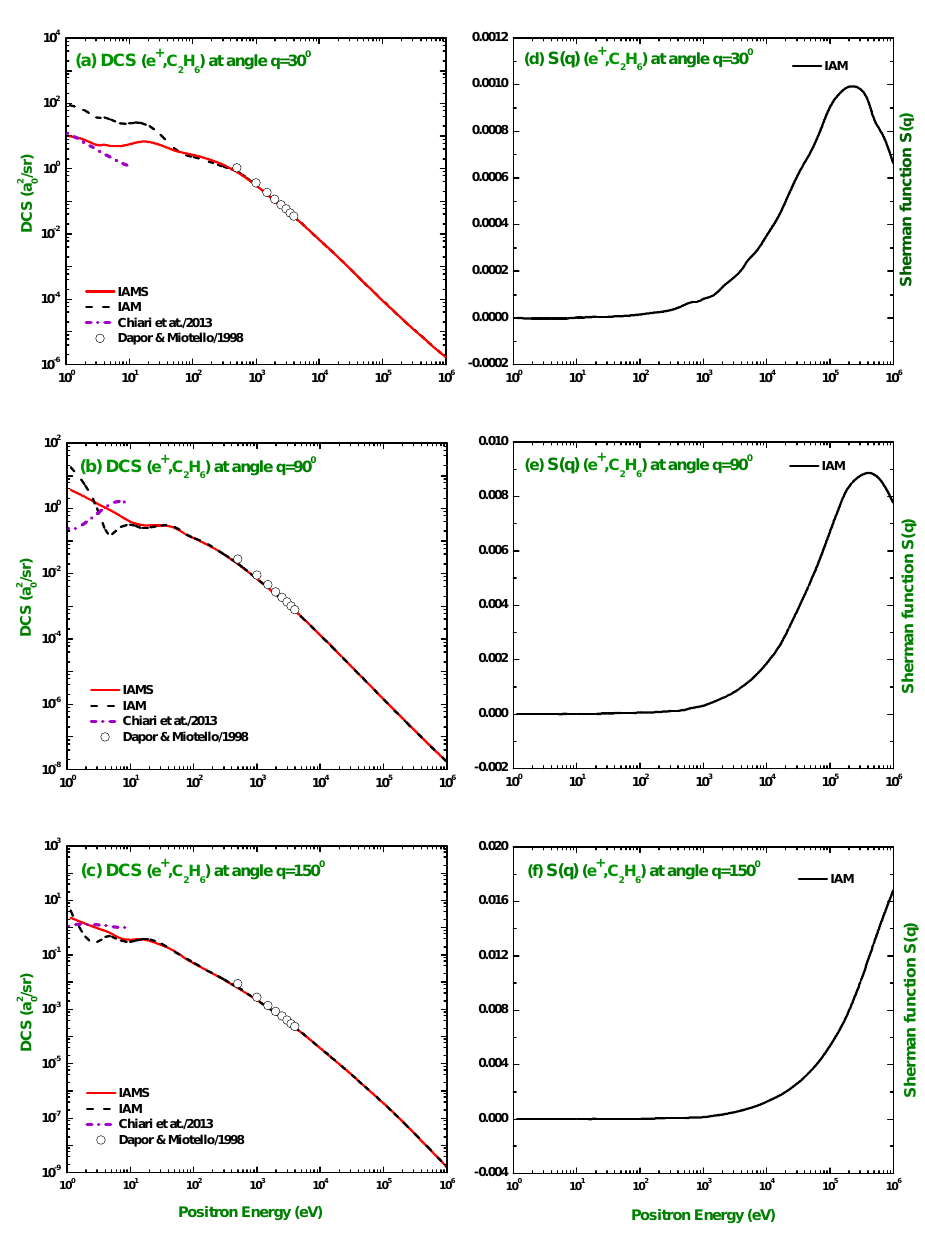
Figure 11. Energy dependence of DCS ( a 2 / sr ) and the Sherman function for the elastic scattering of 0 positrons from C 2 H 6 at angles 30 ◦ , 90 ◦ , and 150 ◦ . Theoretical works: IAM, IAMS, Chiari et al. [28], and Dapor and Miotello